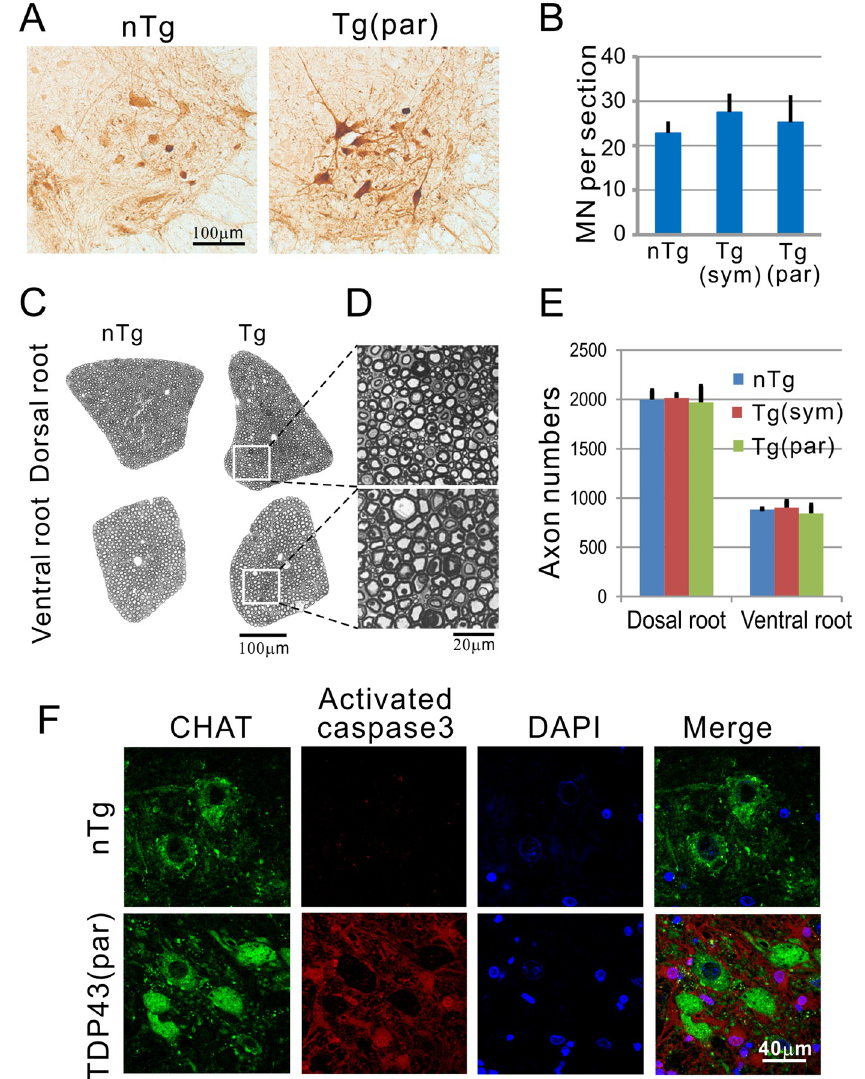
Fig 7. No spinal motor neuron loss in the ventral horn of the lumbar spinal cord. (A) ChAT staining of the ventral horn. (B) Quantification of ChAT-positive cells in the ventral horn of the spinal cord. ChAT-positive cells in the ventral horn were counted in 8–10 sections from the lumbar L4-5 levels of each animal. The average number per section was calculated from each animal. Four animals in each group were further averaged and shown here. Error bars represent standard deviation. (C) The axons in the ventral root and dorsal root remain normal. (D) High magnification of the boxed area in the dorsal and ventral root at the paralysis stage revealed no axon degeneration. (E) Quantification of dorsal and ventral roots showed no difference between Tg and nTg mice. (F) Immunofluorescence staining for activated caspase 3 show increased staining of the neuropils, but no motor neuron staining was detected. sym = symptomatic stage, par = paralyzed